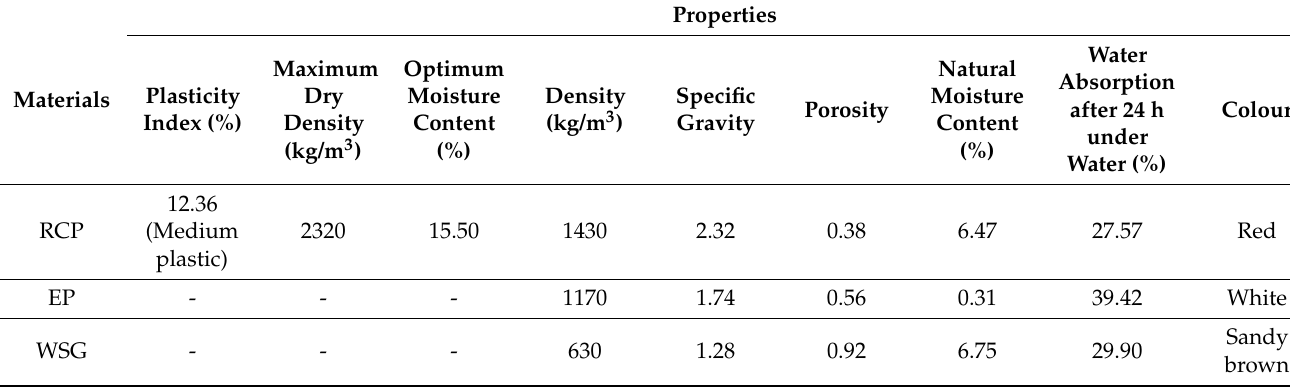
Figure 4. SEM images of raw materials: ( a ) EP; ( b ) WSG; ( c ) RCP. Table 1. Raw materials’ physical properties.